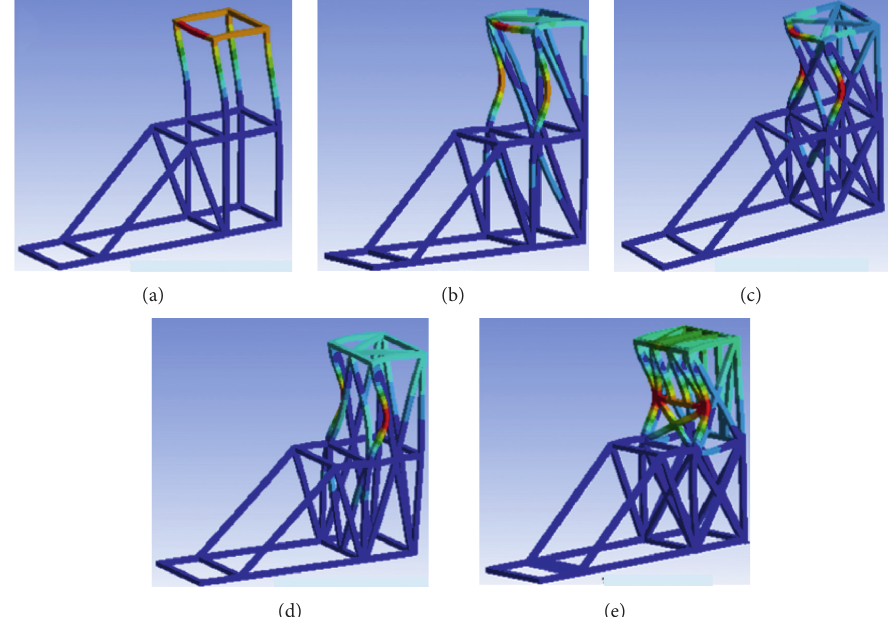
Figure 6: Simulation results comparison of proposed design (a) brace frame, (b) diagonal bracing, (c) cross bracing, (d) V-bracing, and (e) hybrid bracing test